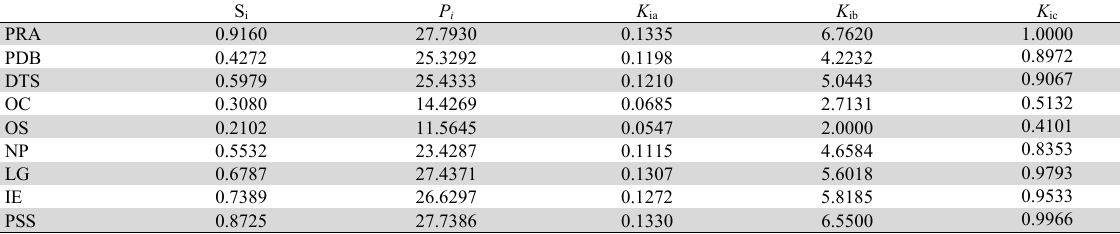
Calculation details obtained using the CoCoSo method S i